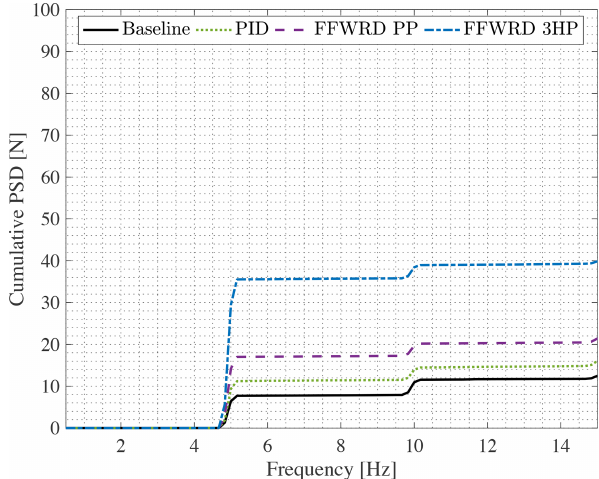
Figure E1. Cumulative power spectral density of the lift amplitude at the reduced frequency of k = 0 .